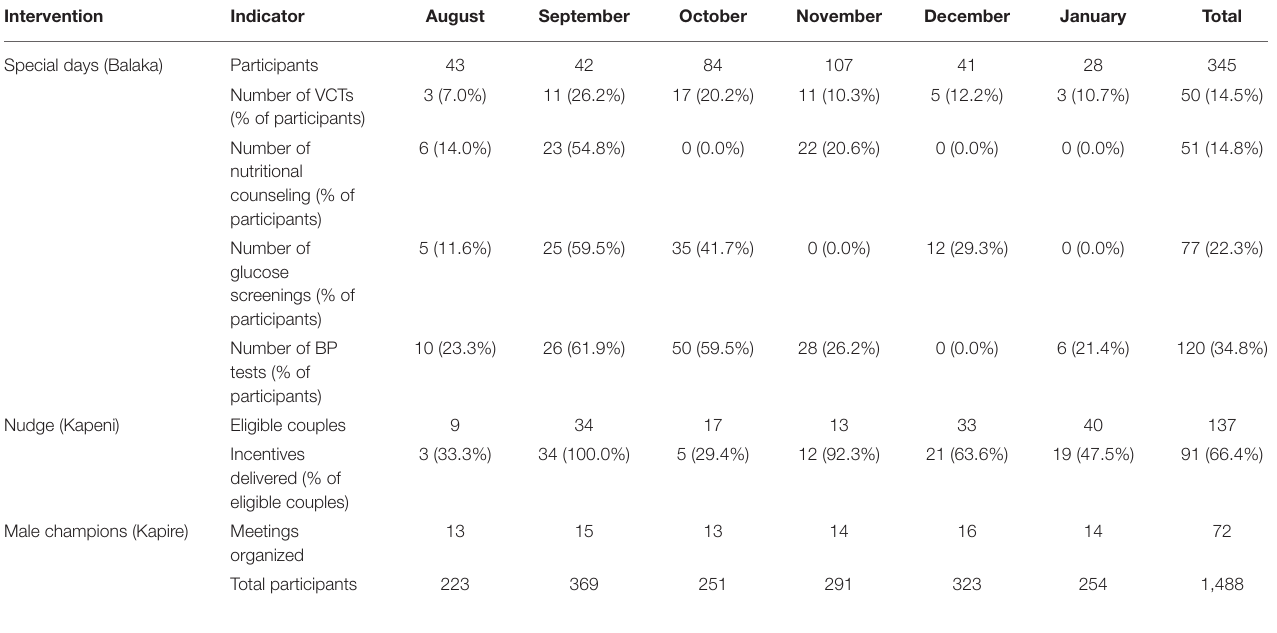
TABLE 2 | Indicators on the delivery of the